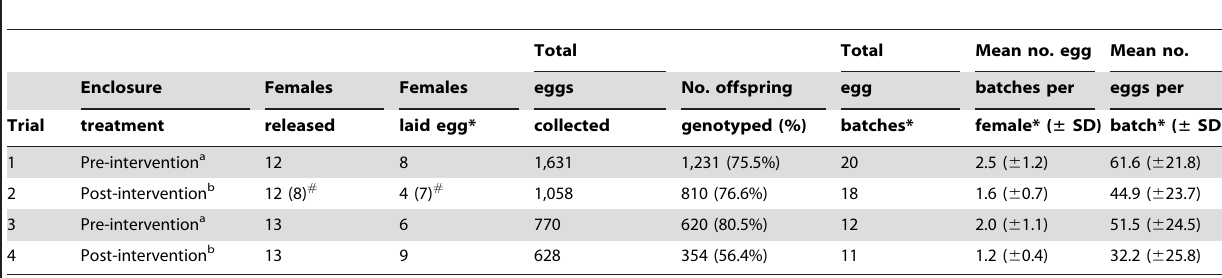
Table 3. Set up and results for targeted container elimination trials inside enclosure.